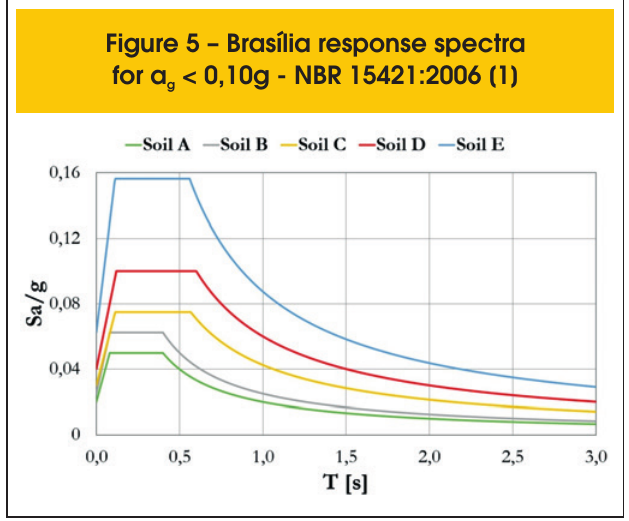
Figure 5 – Brasília response spectra for a < 0,10g - NBR 15421:2006 [1] g